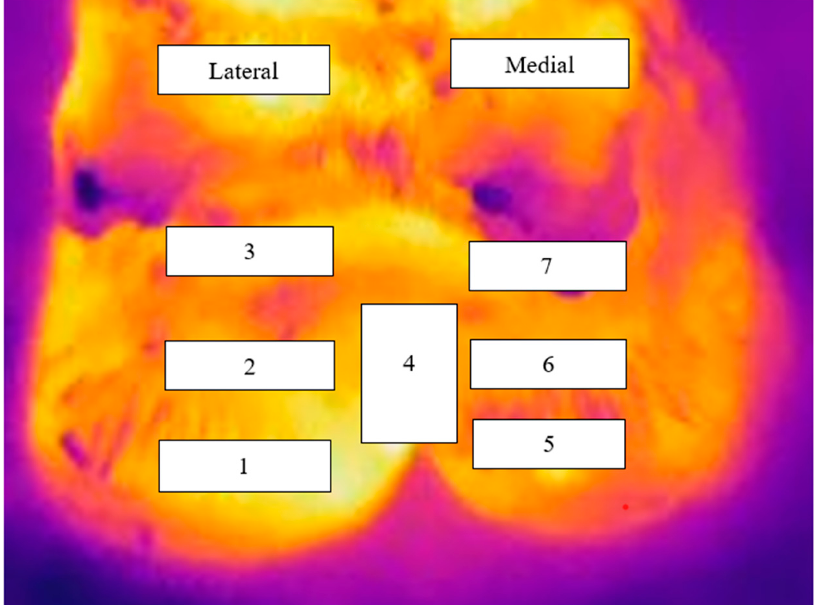
Figure 1. Infrared thermography image of the plantar aspect of the left hind foot overlaid to depict the seven zones for which estimates of surface skin temperature were measured. On the lateral claw; zone 1: coronary band (CB), zone 2: above the coronary band (ACB), zone 3: below accessory digit (BAD), zone 4: interdigital space (IDS). Zones 5 to 7 are the equivalent to zones 1 to 3 but on the medial claw.